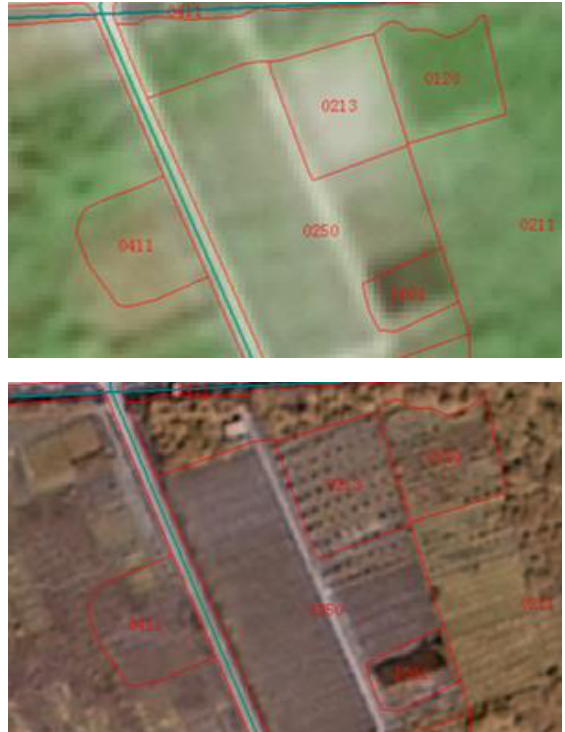
Figure 3 . Pseudo update phenomenon due to resolution and time phase changes of two-phase